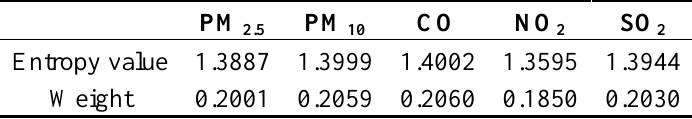
Table 4. Entropy values and weights of